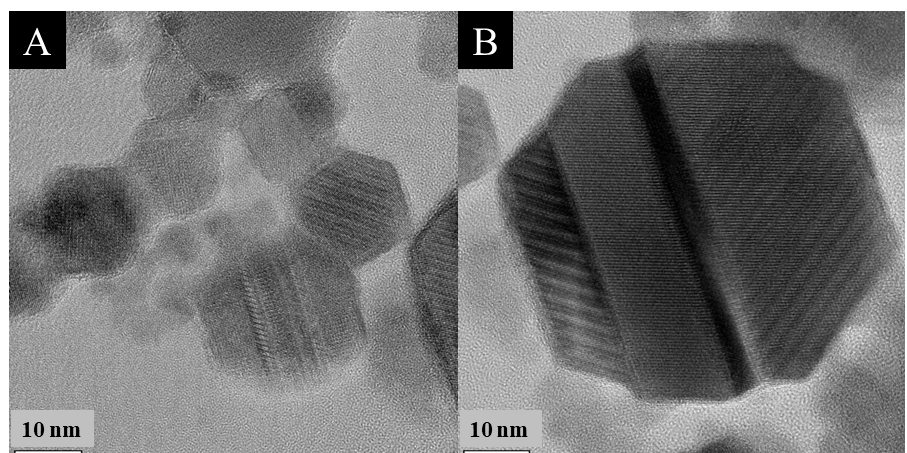
Figure 3. ( A , B ) High magnification TEM images of Fe 2 O 3 nanoparticles after HEBM, which show increased surface roughness of the particles.